Question: Produce a descriptive caption suitable for publication.
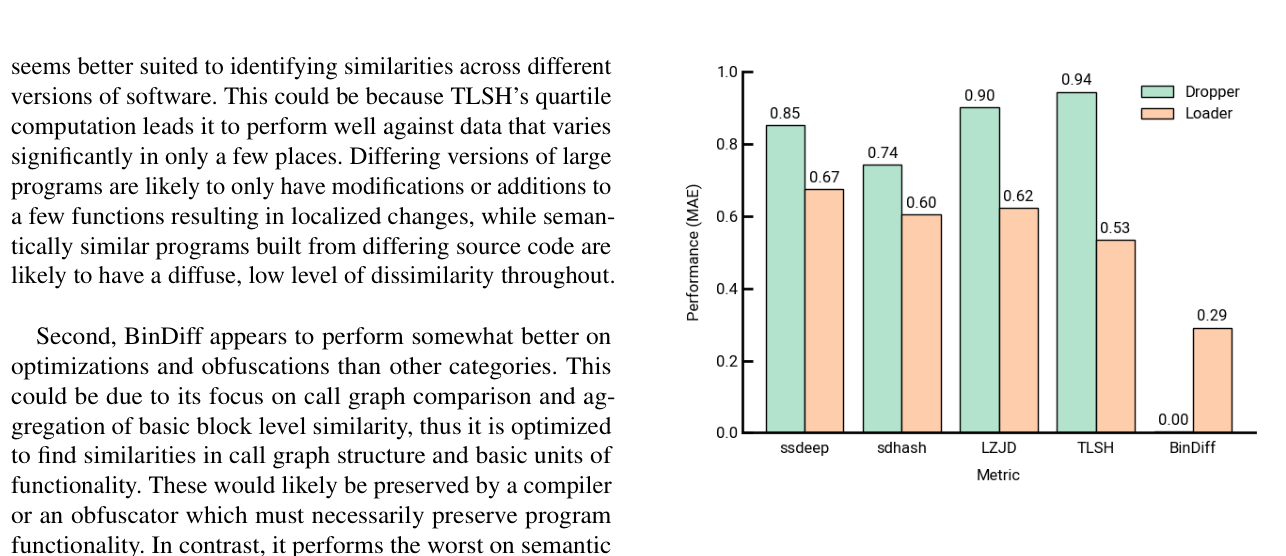
Answer: Program similarity metric performance on Cos- micDuke malware samples by sample category - lower is better.